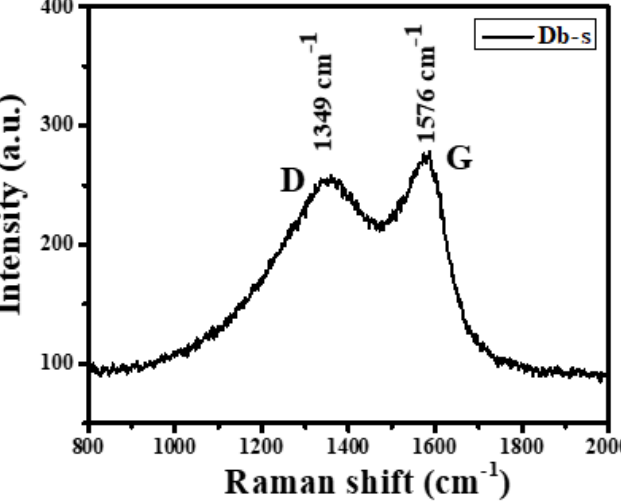
Figure 3. Raman spectra of the as-prepared AC (Db-s).